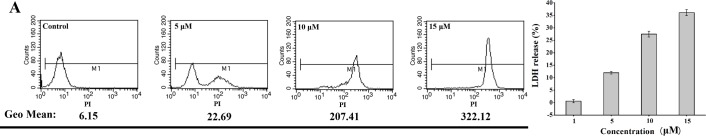
Membrane permeability changes of BGC-823 cells by monitoring PI and LDH.The cells were incubated with increasing peptide concentrations for 1 h at 37 oC. (A) Quantitative comparisons of fluorescence intensity (in Geomean) at various concentrations were analyzed by flow cytometry. (B) LDH in the supernatant was measured with a microplate reader at 450 nm. Cells without treatment or lysed with triton X-100 was used as negative and positive controls, respectively. LDH activity was calculated as the percentage of experimental group and positive control, after subtraction of negative control respectively (*P<0.005). Data are the mean ± SD of three independent experiments.